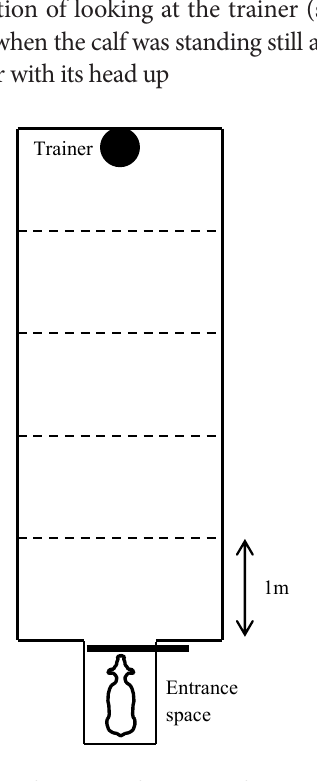
Figure 1. Diagram of the arena for the test for reactions to the stationary trainer (width, 200 cm; length, 500 cm; height, 180 cm). Solid and bold lines represent the wood panel and slide gate of the calf entrance, respectively. The trainer stood at the position of the black dot during a test.